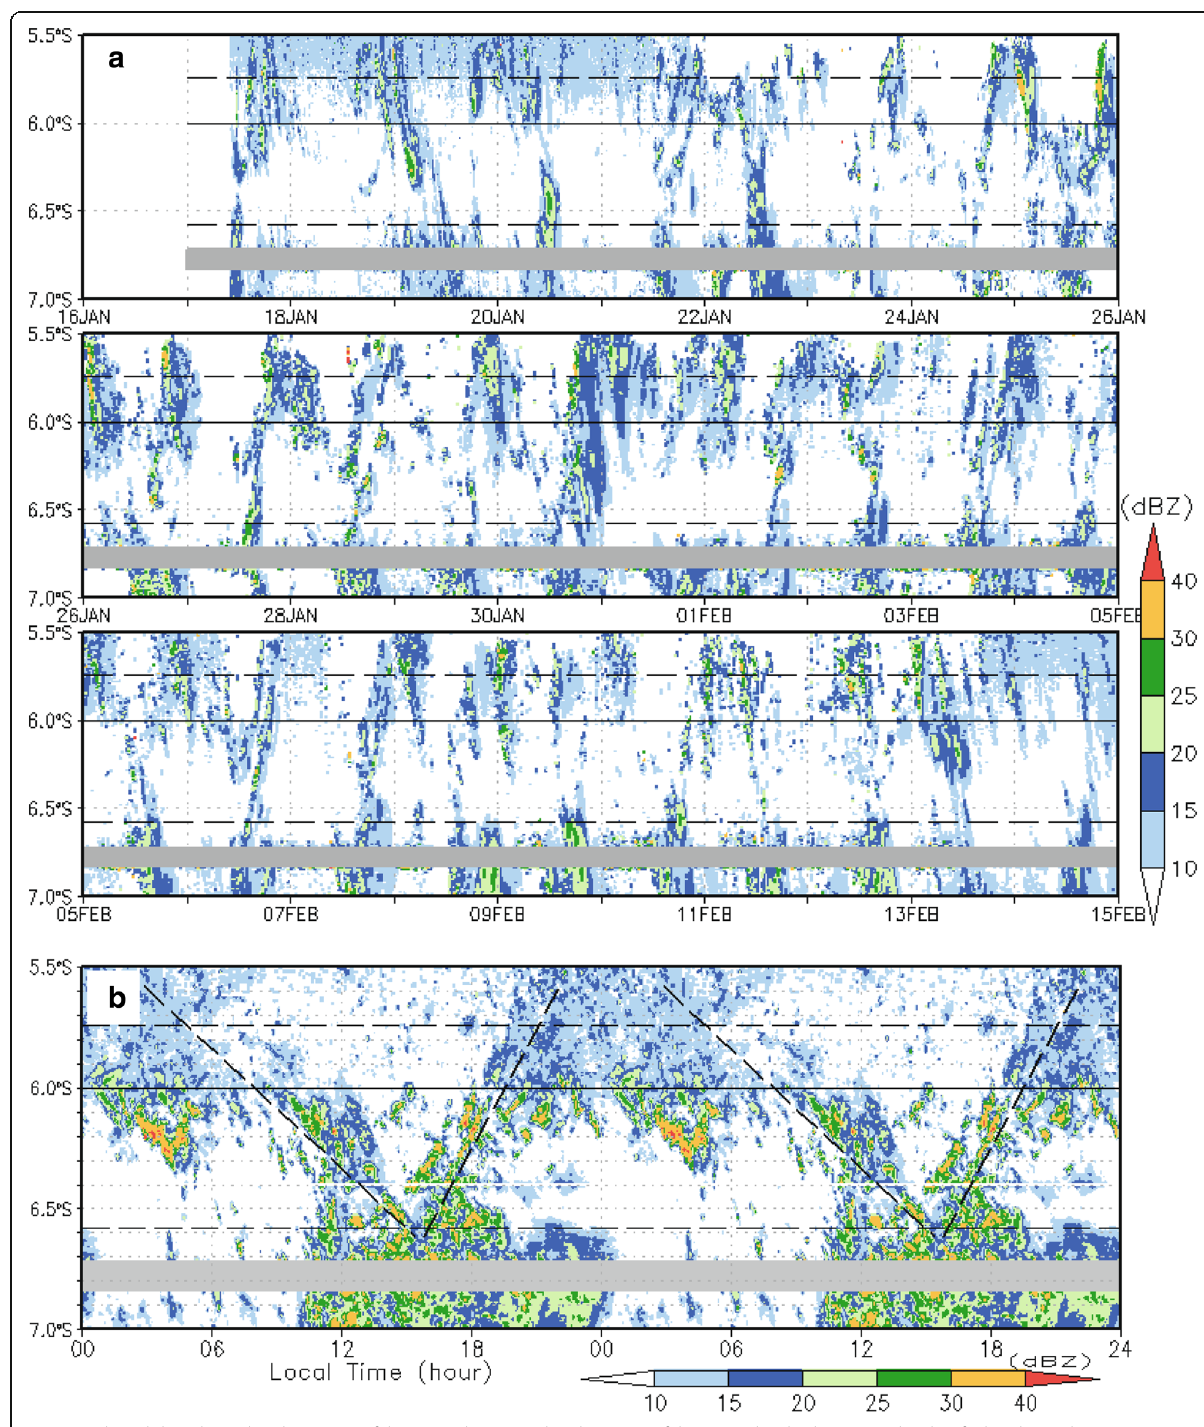
Fig. 6 Daily and diurnal meridional variations of the CDR echo. a Meridional variation of the CDR echo distribution at a height of 2 km during the campaign period averaged over a 100-km width (106.25° E – 107.15° E) in the east – west direction from the Serpong CDR site as shown by the rectangle with dashed red lines in Fig. 1b and b its mean diurnal cycle (duplicated twice). Data in gray-shaded areas (6.83° S – 6.72° S) were disregarded from the analyses because of serious ground clutter. Thin black solid horizontal lines indicate the averaged latitudinal location of the coastline (6.0° S) of the western part of Jawa Island as shown in Fig. 1b. Latitudinal locations of Pramuka (5.74° S) and Bogor (6.58° S) are also indicated by thin dashed horizontal black lines. Thick dashed lines in panel b indicate the estimated speed of DRMMs at approximately 2 m s − 1 (5 m s − 1 ) southward (northward) during the early morning (late evening) for reference. Note that, however, these DRMM dashed lines show period averaged characteristics created by superposition of diurnal cycles that varied much from day to